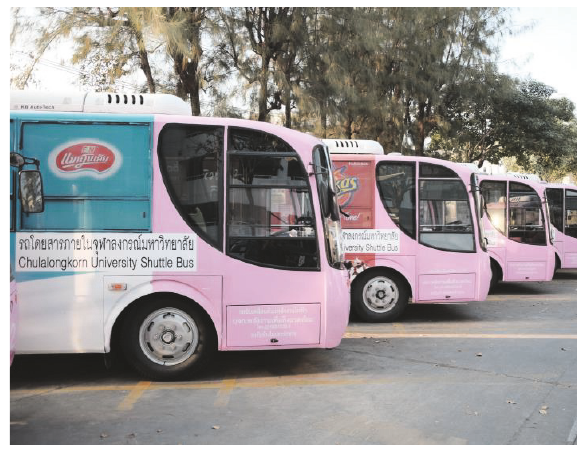
Figure 2: Campus buses used in the